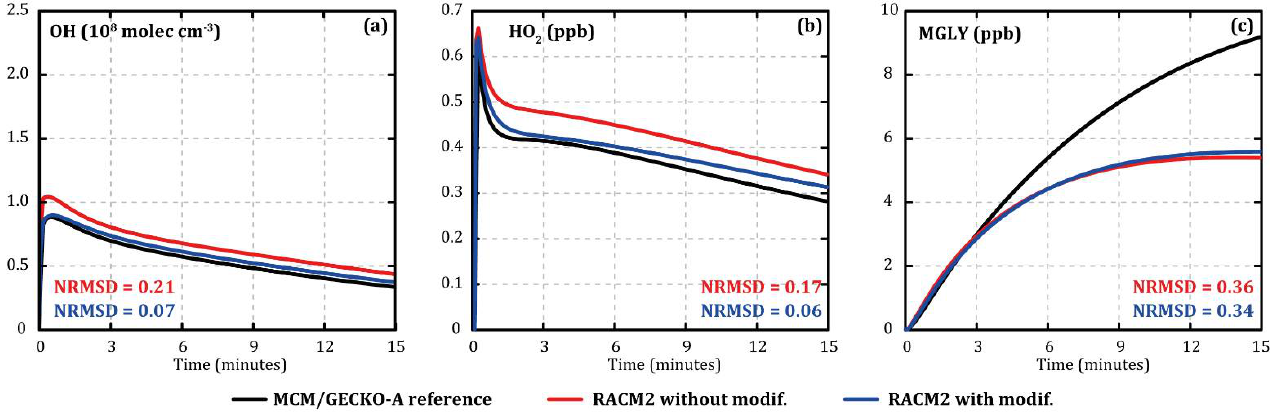
Figure 2. Temporal evolution of the concentrations of OH ( a ), HO 2 ( b ), and methylglyoxal ( c ) simulated with MCM/GECKO-A (black lines), RACM2 (red lines), and modified RACM2 (blue lines) during o-xylene oxidation. Simulated concentrations are shown for oxidation performed at a temperature of 7 °C, an RH of 24%, 120 ppb of IPN, and 112 ppb of o-xylene.